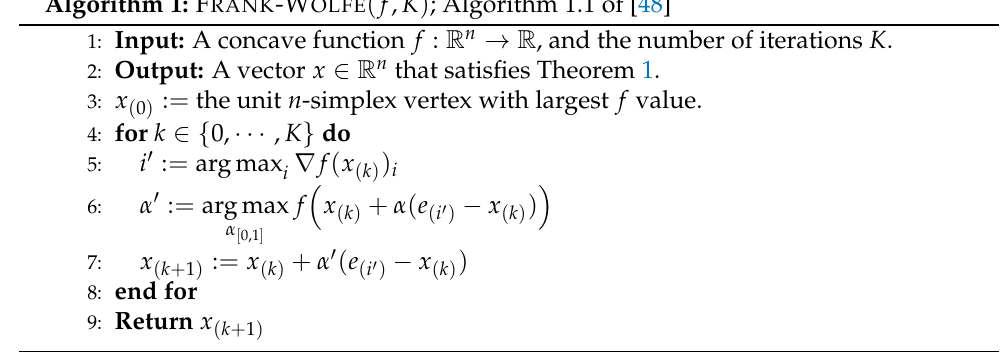
Algorithm 1: F RANK -W OLFE ( f , K ) ; Algorithm 1.1 of [48]